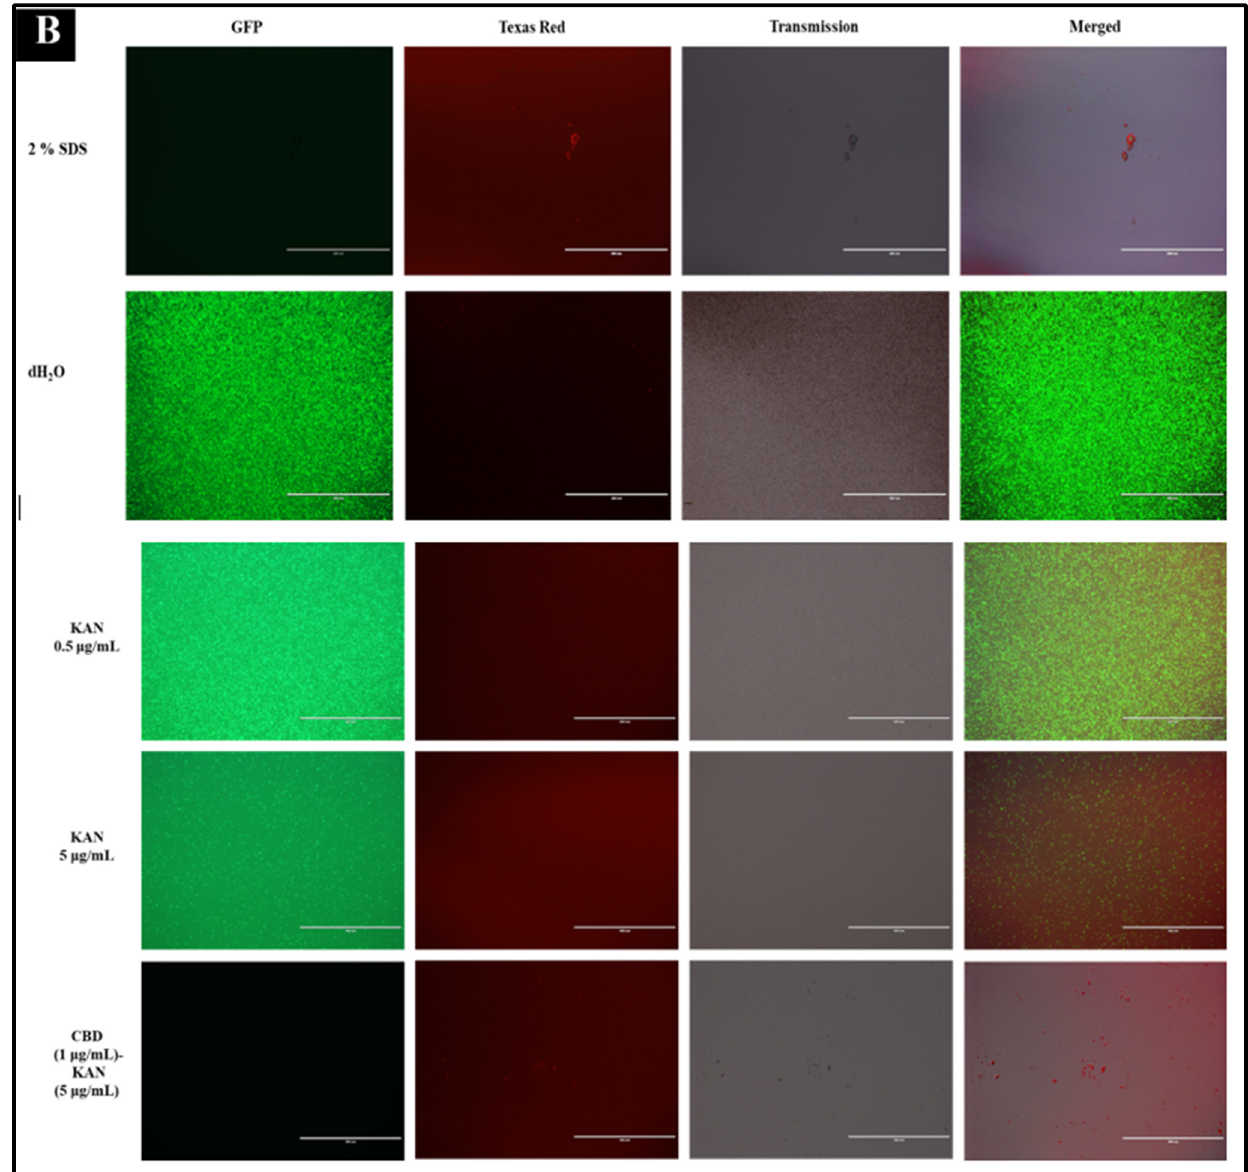
Figure 2. Synergistic analysis of kanamycin and CBD co-treatment of S. typhimurium . ( A ) Potential synergistic activity was observed at 5 μ g/mL kanamycin and 1 μ g/mL CBD co-treatment. Data presented as average OD 600 ± SEM. ( B ) Immunofluorescence staining analysis positive (2% SDS) and negative (dH 2 O) controls. Immunofluorescence staining of S. typhimurium treated with kanamycin at 0.5 and 5 μ g/mL as well as the observed synergistic combination of 5 μ g/mL kanamycin and 1 μ g/mL CBD.